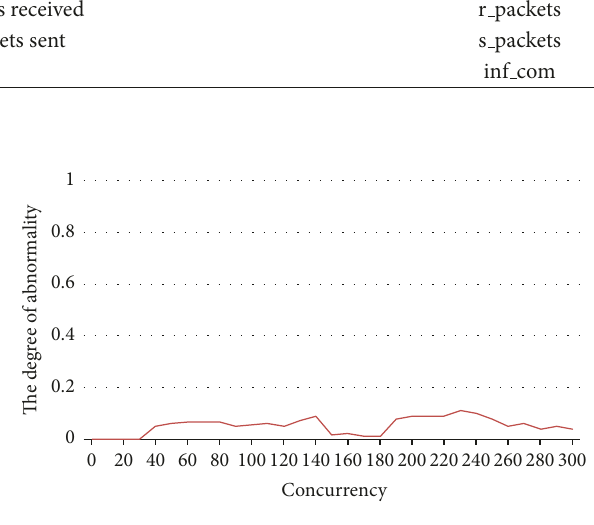
Figure 3: Abnormal degree change with concurrency.